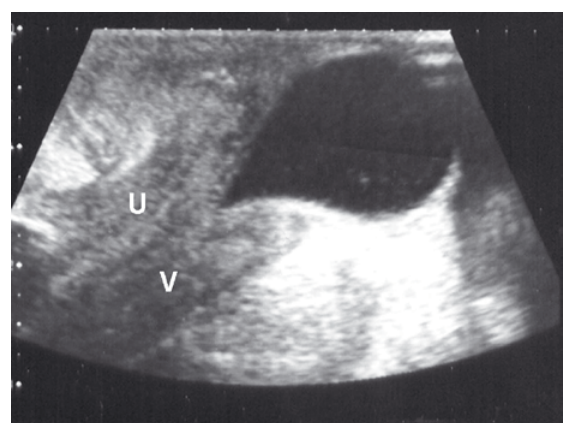
Figure 2. US examination shows the proximal segment of the cyst is seen to lie between the urethra and vagina. U:Urethra; V:Vagina.